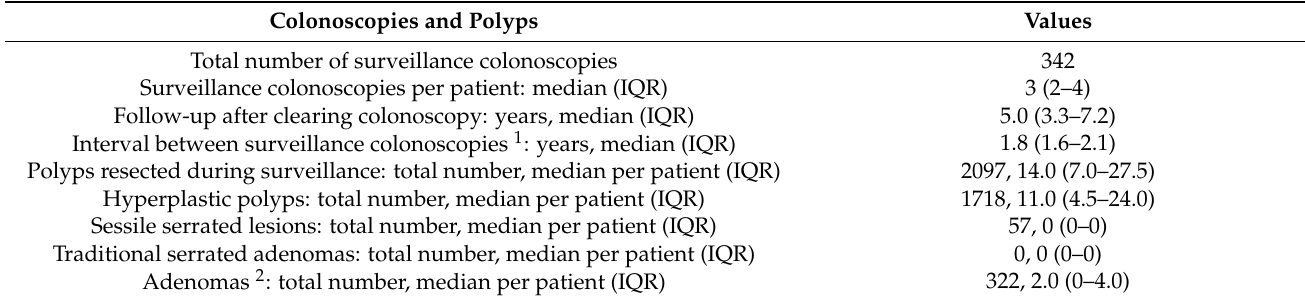
Table 2. Surveillance colonoscopies ( n =